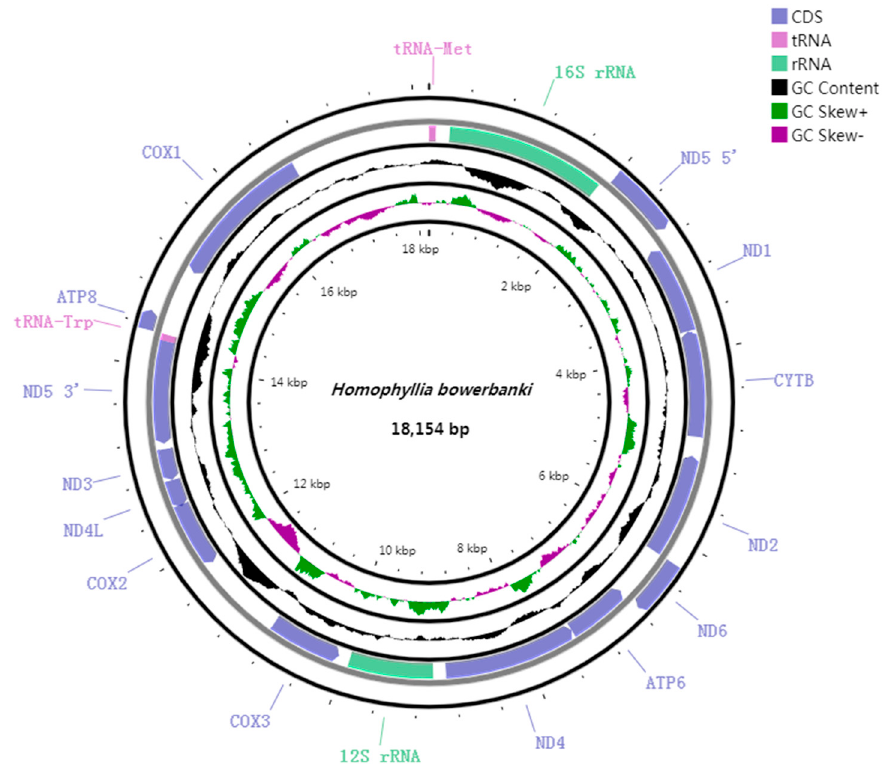
Figure 2. Circular map of the mitogenome of H. bowerbanki . COX1, COX2, and COX3 refer to the cytochrome oxidase subunits, ND1–ND6 refer to NADH dehydrogenase components, and CYTB refers to cytochrome b. All of the seventeen genes are encoded on H strand.